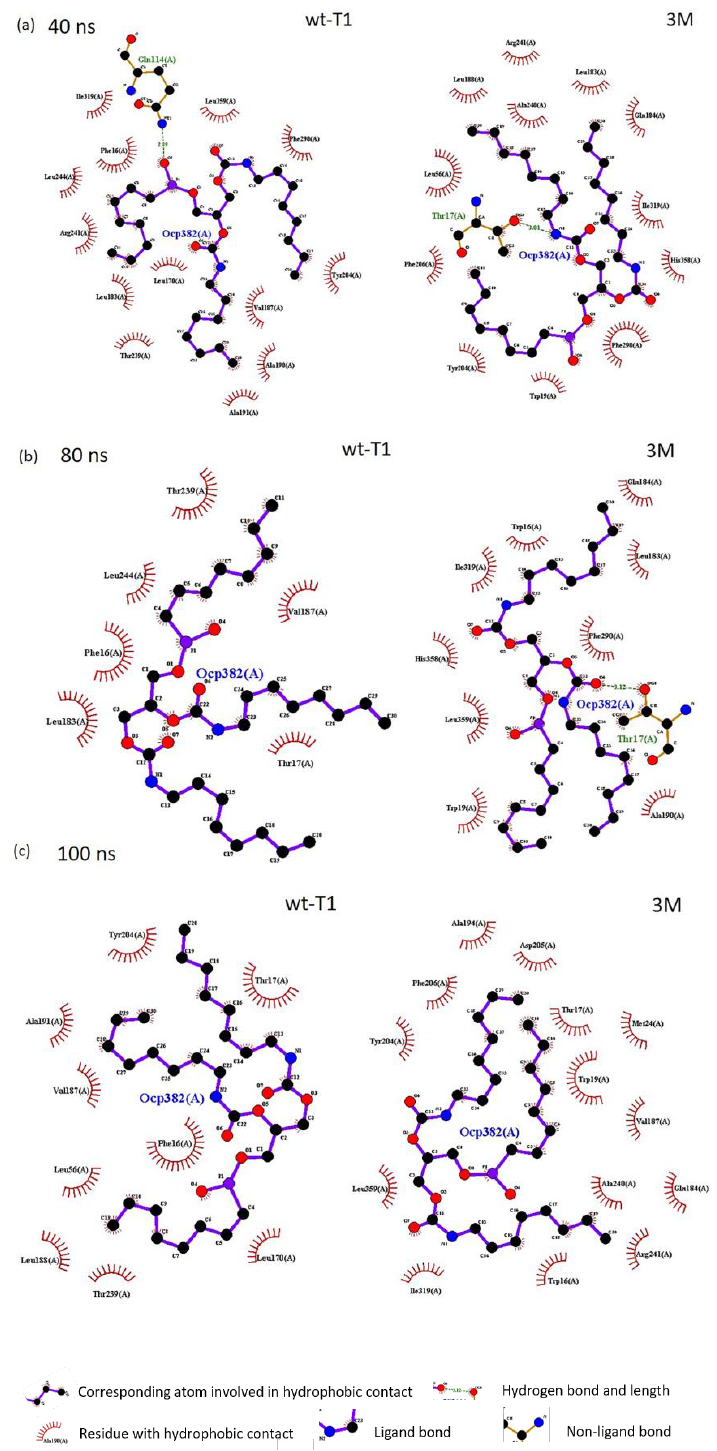
Figure 9. Snapshot of the structure complex of wt-T1 and 3M variant with a substrate analogue OCP (RC-(RP, SP)-1,2-dioctylcarbamoyl-glycero-3-O-octylphosphonate (purple) extracted from MD simulations trajectories showing ligand interaction with amino acid surrounding the active site: ( a ) 40 ns. ( b ) 80 ns. ( c ) 100 ns. Hydrogen–bond interactions were shown as green dotted lines. Hydrophobic interactions are represented by the red spike. The figures were generated by LigPlot+ (version